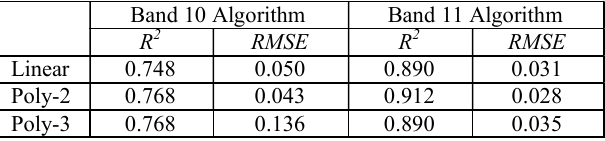
Table 8. Performance of the Sea Surface Temperature